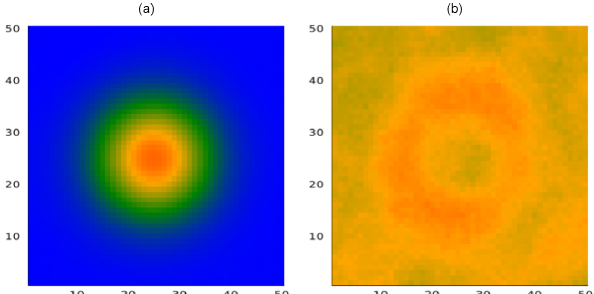
Figure 7. Initial ore belief. Panel (a) shows the mean mineralization from the prior belief at each point in the exploration area. Panel (b) shows the marginal standard deviation of mineralization at each point.